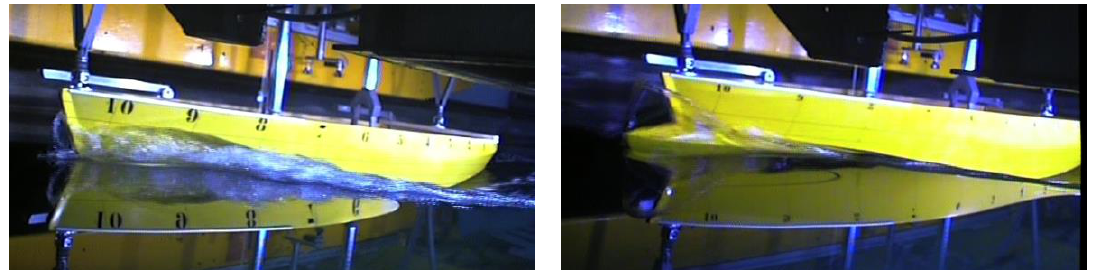
Figure 19. FAO1 vs. FAO2 at 7.5 kn, Heavy condition.